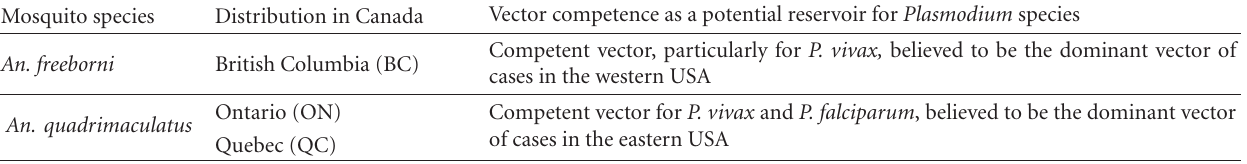
Table 2: Anopheles species of Canada and their potential competence as malarial